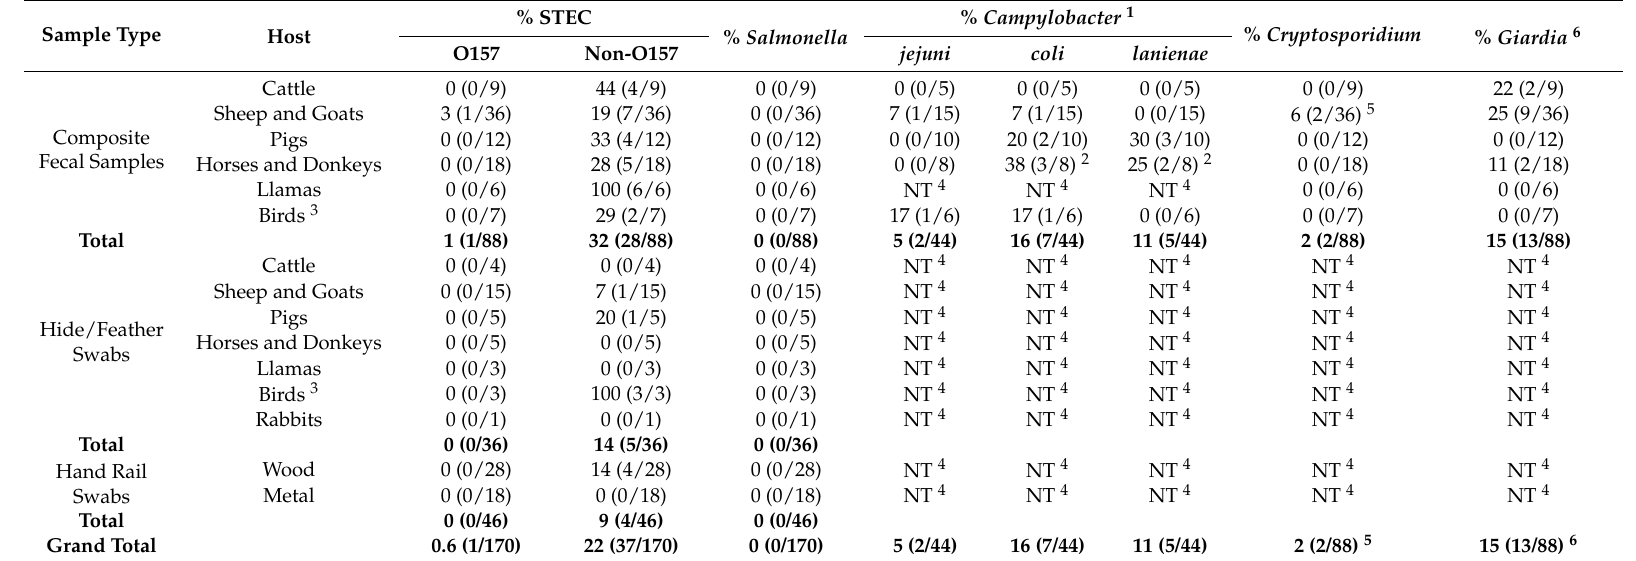
Table 2. Prevalence of O157 and the top 6 non-O157 STEC, Salmonella , Campylobacter spp., Cryptosporidium and Giardia from samples collected at petting zoos in Canada